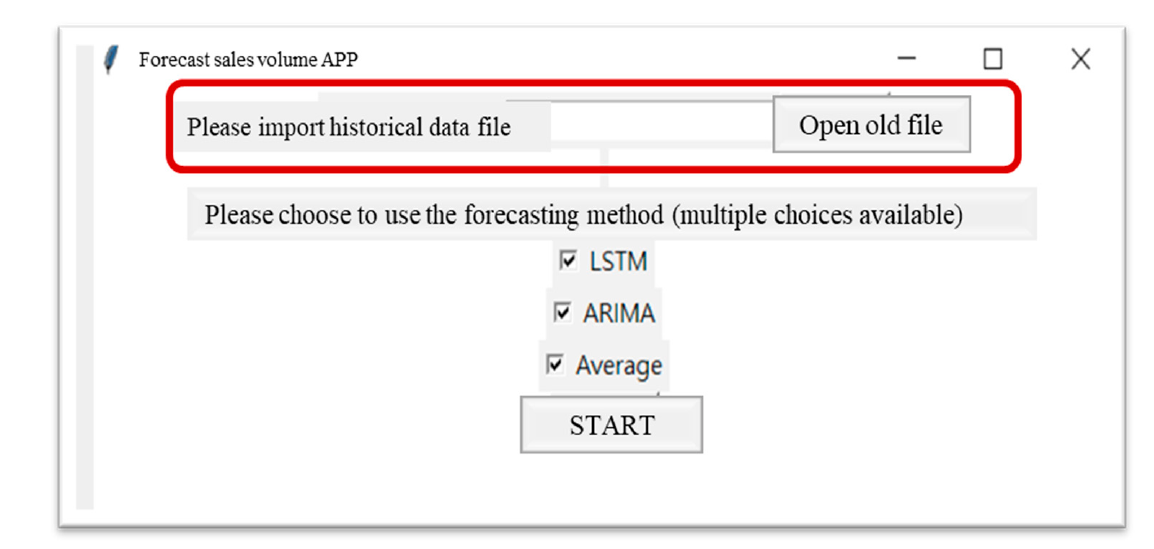
Figure 7. Select the forecast item number.